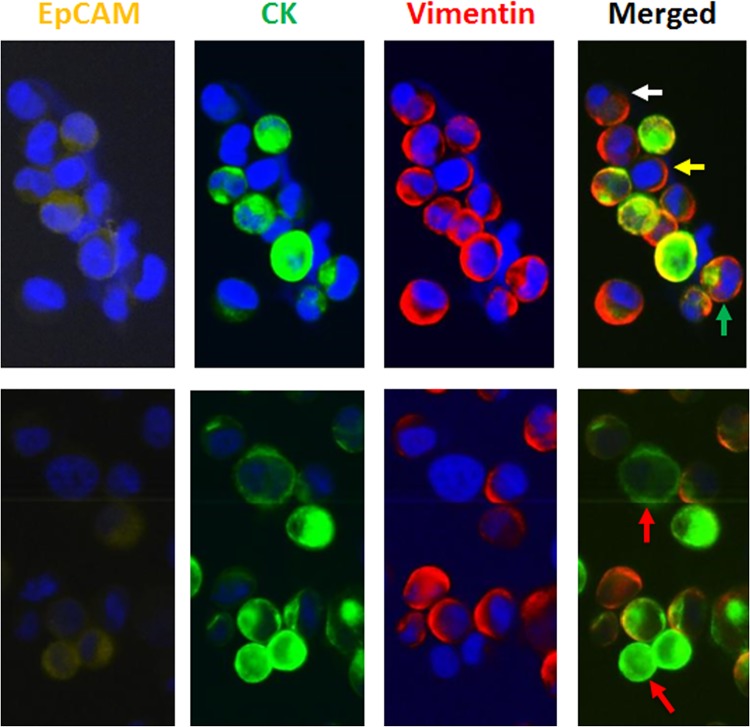
EMT expressions on PC3 cell lines.Various types of signals combination were presented including cells purely expressing epithelial markers without Vimentin (red arrow), purely expressing Vimentin without either EpCAM or CK (white arrow), expressing EpCAM but no CK (yellow arrow), and expressing CK but no EpCAM (green arrow).